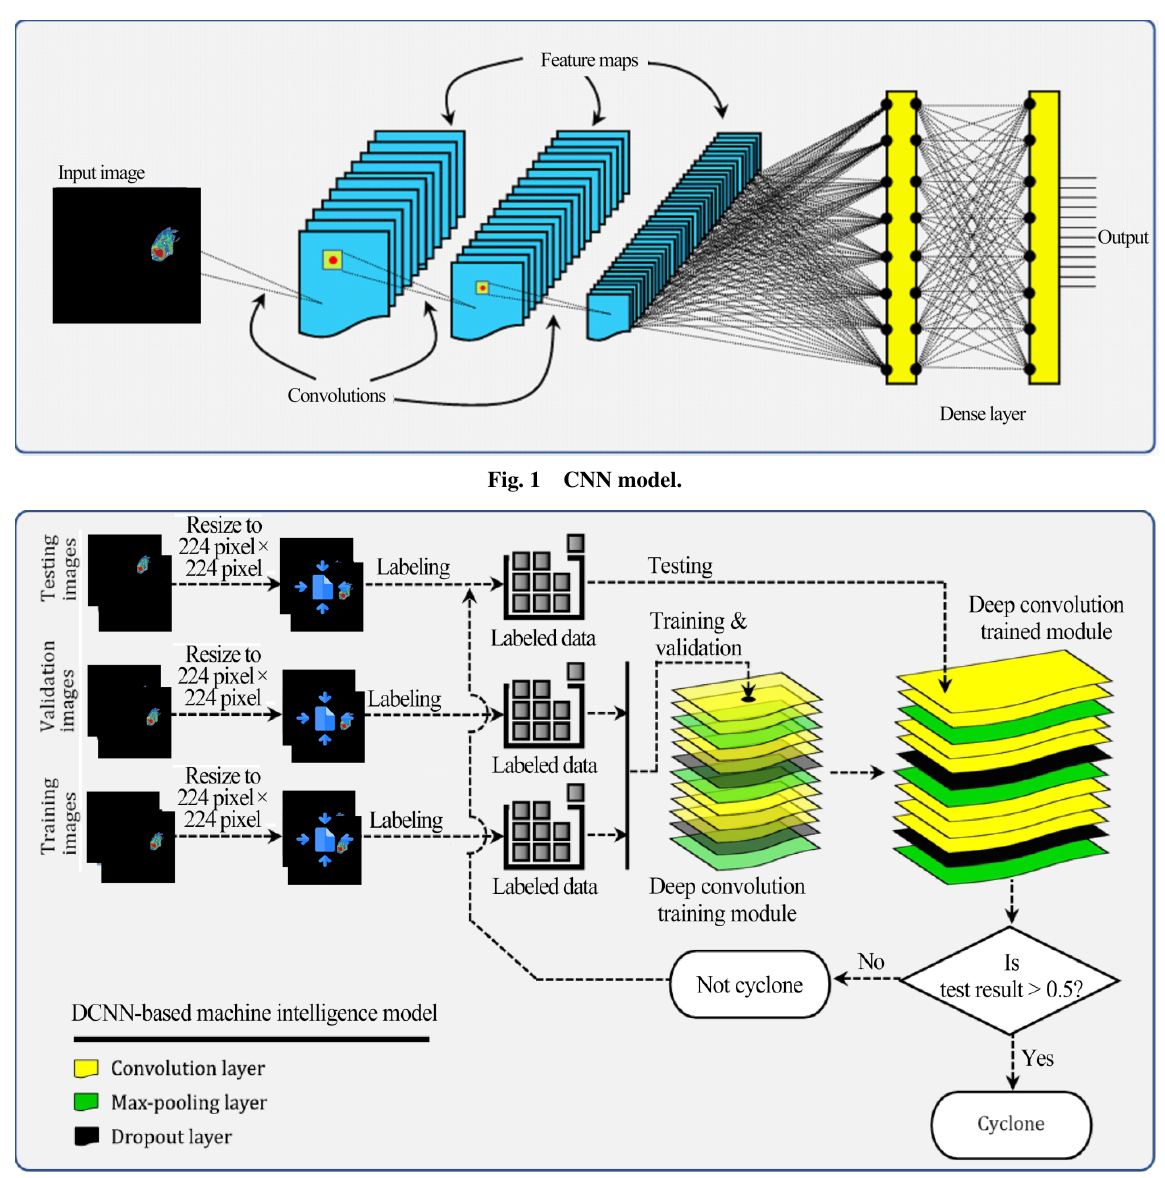
Fig. 2 DCNN-based machine intelligence model for cyclone